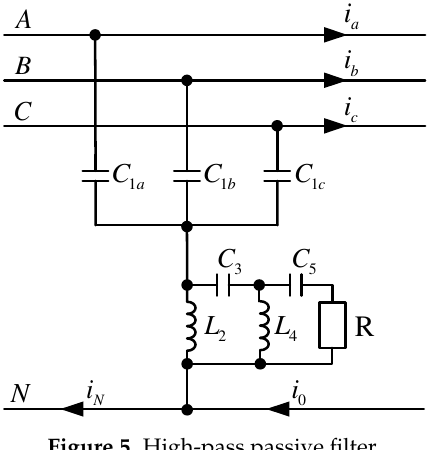
Figure 5. High-pass passive